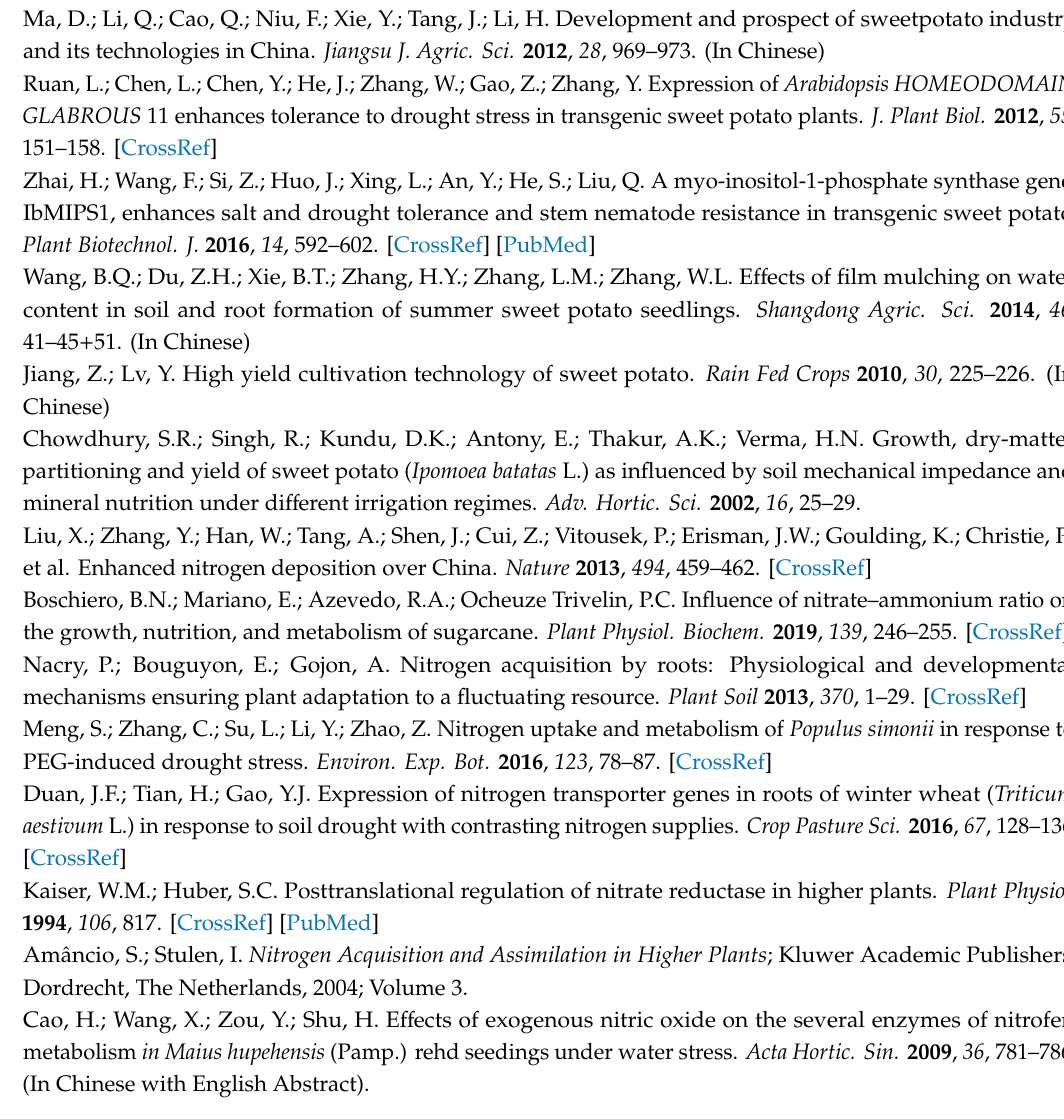
Table S1: Specific primers for gene amplification. Table S2: Changes of Pn and gs in sweet potato leaves at one day after PEG-drought